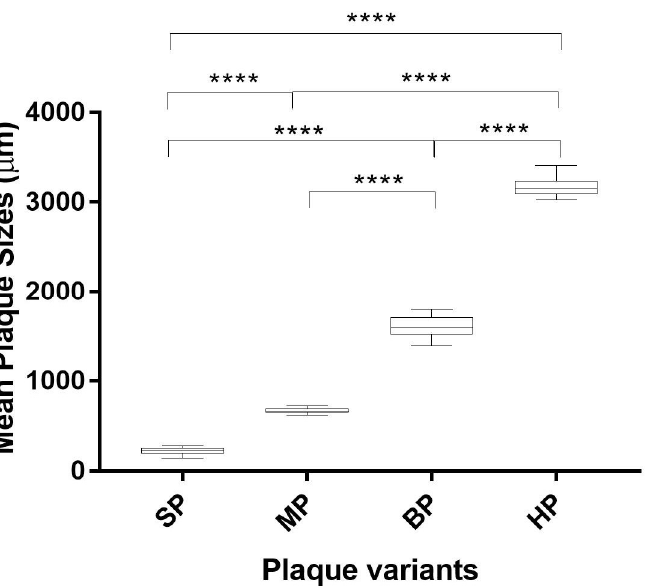
Figure 2. Diameters of 40 plaques representing each plaque variant in monolayers of RD were measured using the DS-L3 viewer with the Nikon’s NIS-Elements software and analyzed by Graph pad prism 7.04. The mean size of all plaque variants were compared against all plaque variants in RD cells. Error bars indicate standard deviation of average. Statistical analysis, one-way ANOVA, **** p < 0.0001.